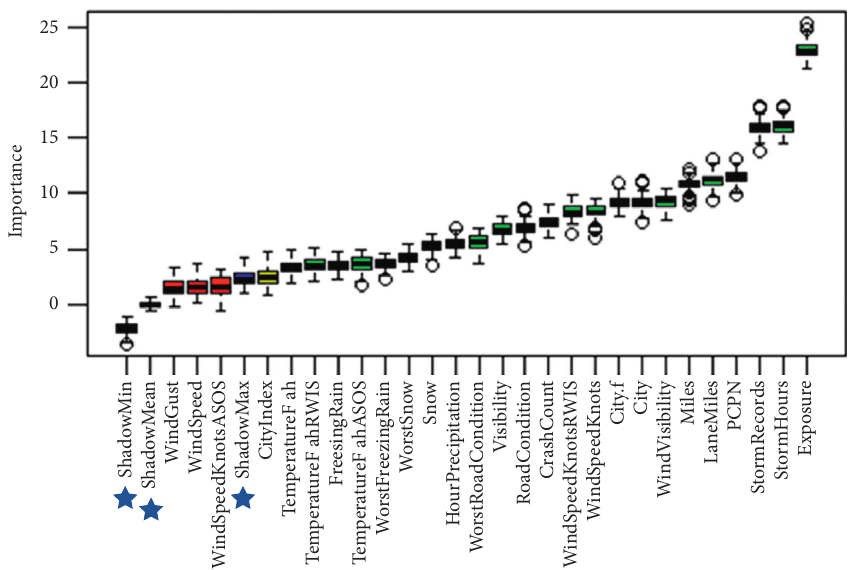
Figure 5: The importance scores of weather and traffic variables.